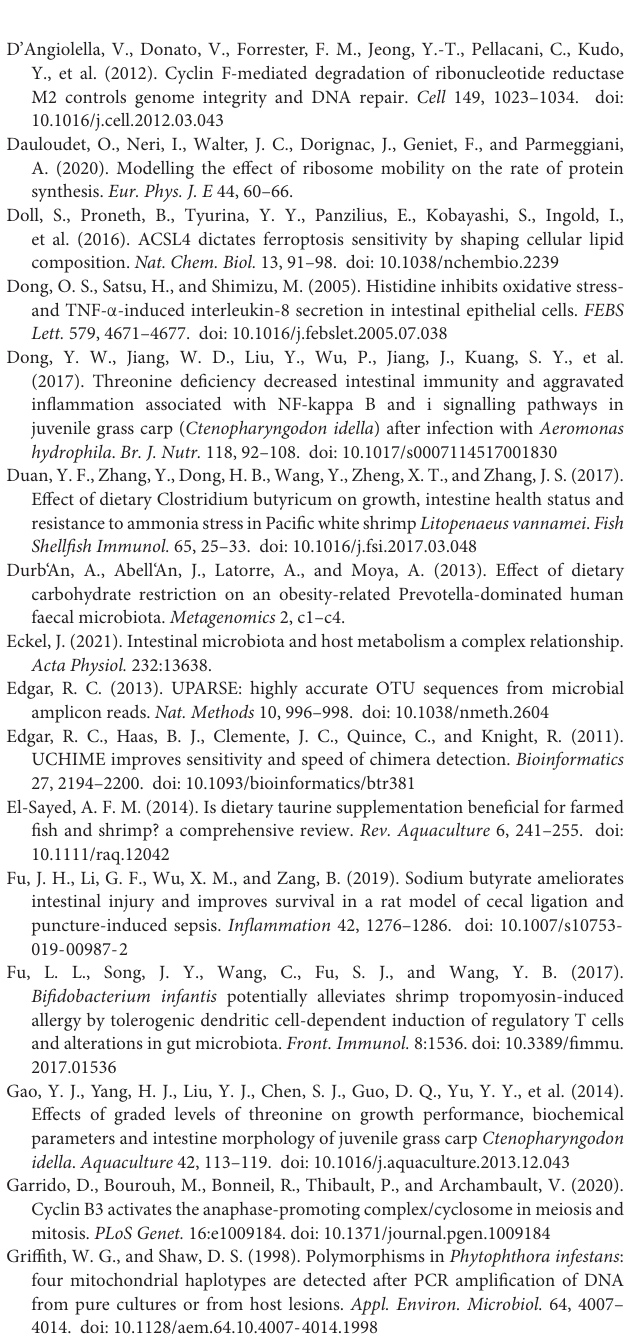
Supplementary Figure 9 | ROC analysis for discrimination among the groups for the potential biomarker metabolites in positive and negative modes. Supplementary Table 1 | Composition of the diets. Supplementary Table 2 | Amino acid profile (%) of the diets used in the experiment. Supplementary Table 3 | Primers sequences used for real-time quantitative